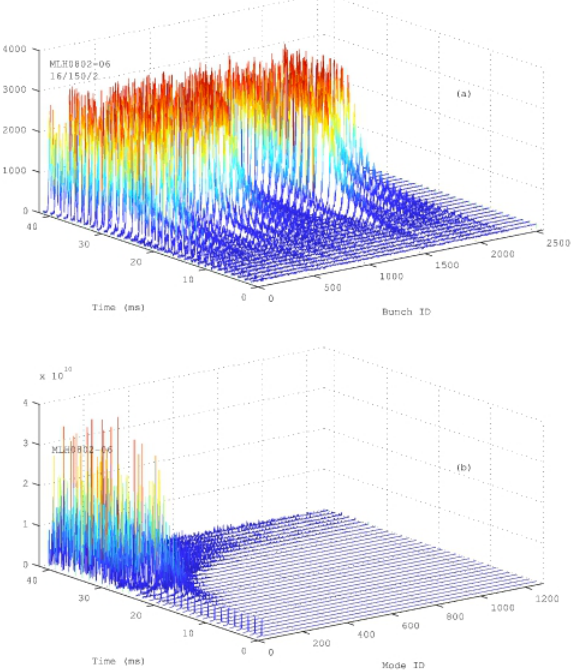
FIG. 10. (Color) Example of a growing transient due to horizontal instability in the KEKB LER: (a) time evolution of the betatron amplitude for each bunch, (b) time evolution of the modes of the instability.